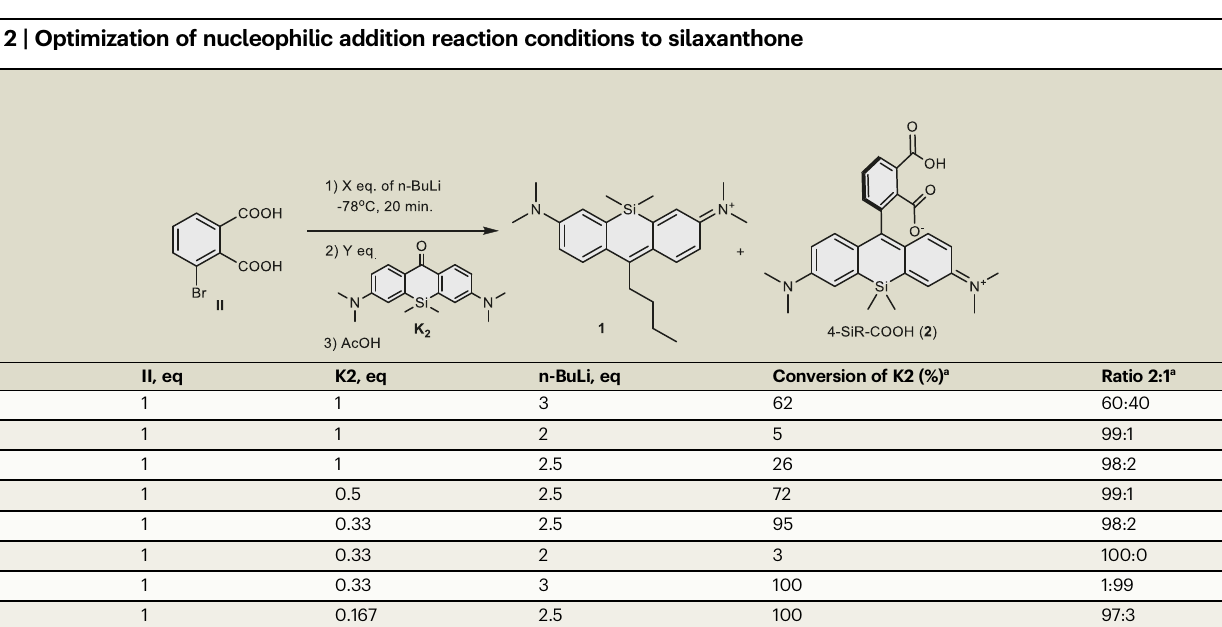
2.0 trace II 2.2